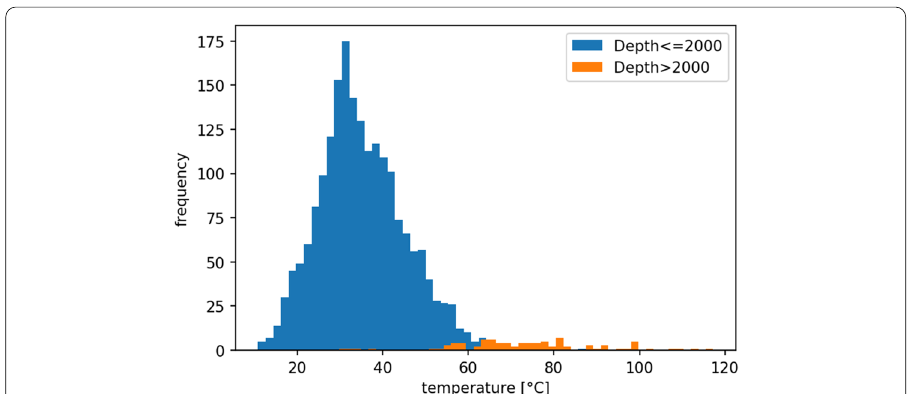
Fig. 9 Target (BHT) distributions for well-represented and underrepresented test